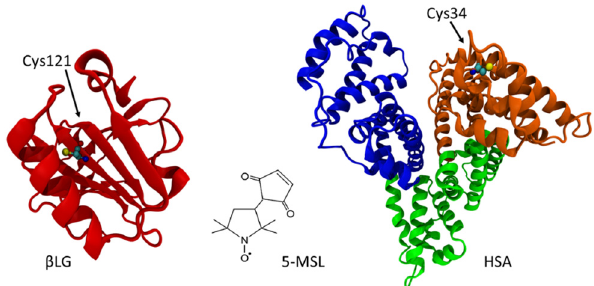
Figure 1: Crystal structure of β LG ( PDB ID 3NPO; [ 38 ]) and HSA ( PDB ID 1AO6; [ 39 ]) . Cysteins in the proteins are indicated with the ball - and - stick model. The structure of 5 - MSL is also